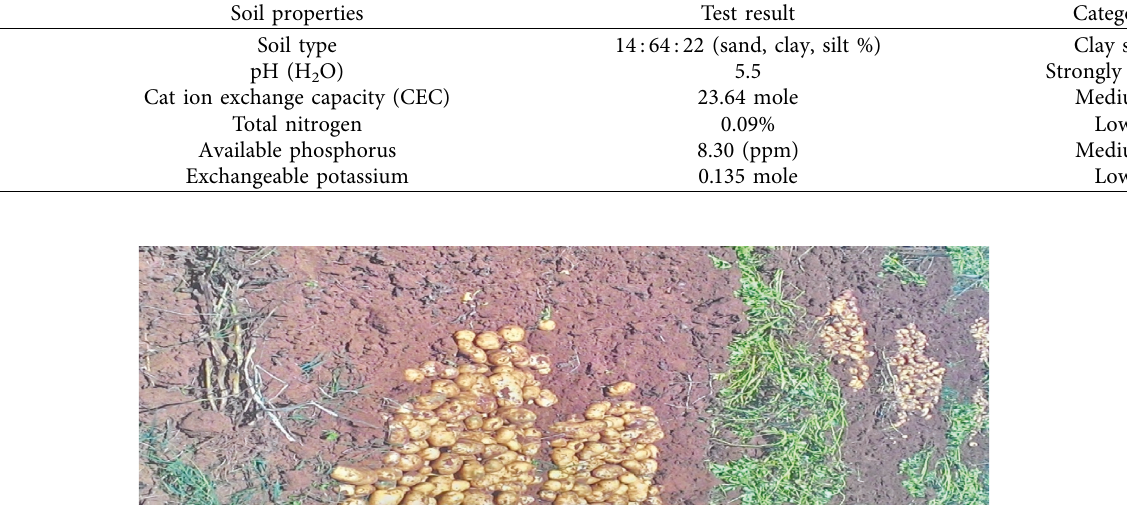
Figure 1: Yield harvesting operation photo